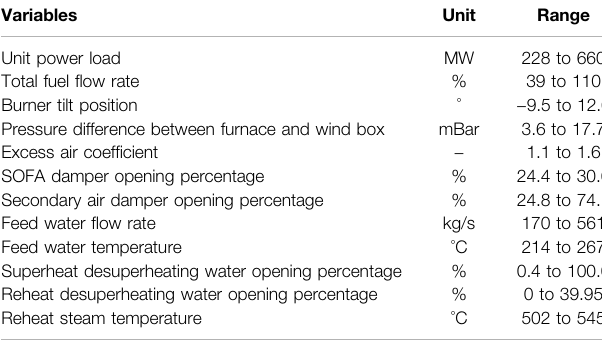
TABLE 1 | Unit and range of each parameter. Variables